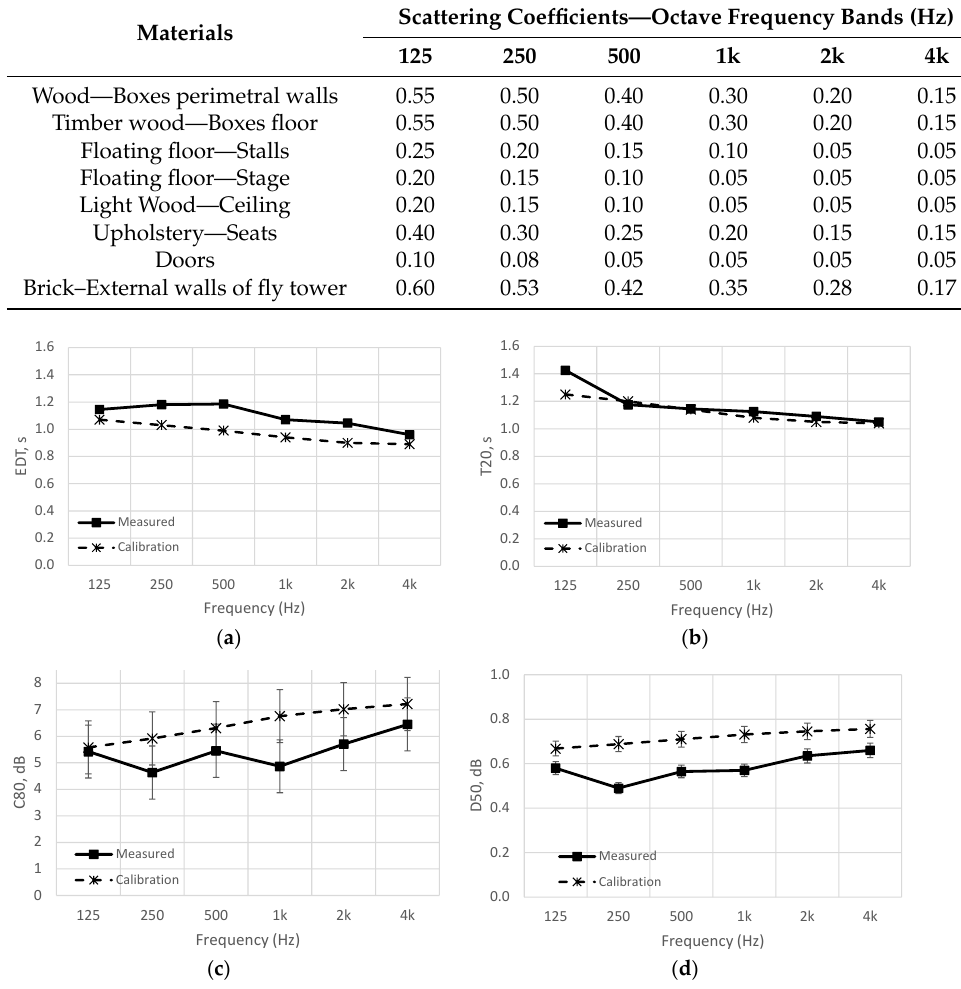
Figure 9. Acoustic calibration based on main acoustic parameters: early decay time ( a ), reverberation time ( b ), music clarity index ( c ), and definition ( d ).